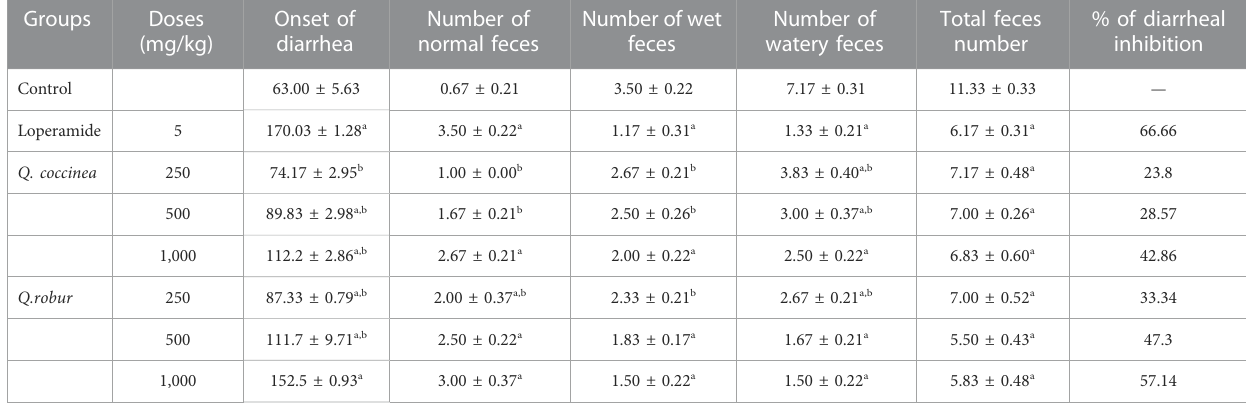
TABLE 3 Effects of Q. coccinea and Q.robur AME on fecal characteristics in castor oil-induced diarrhea in mice.